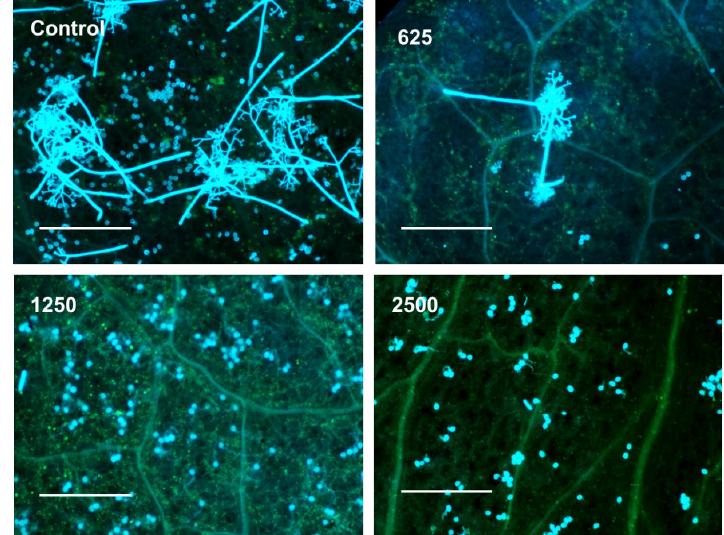
Figure 3. Fluorescence micrographs showing the effect of formulated TTO (625, 1250, and 2500 µg/mL a.i.) on sporulation of B. lactucae into lettuce leaves. Sporophores and spores fluoresce blue. Bar = 250 µm. Photos were taken at 5 d after inoculation. Table 5. The effect of Timorex Gold on conidial germination at 24 h and sporophore formation at 5 dpi of B. lactucae on detached cotyledons of lettuce a . Treatment Percent Germinating Spores Concentration, ppm a.i 24 h